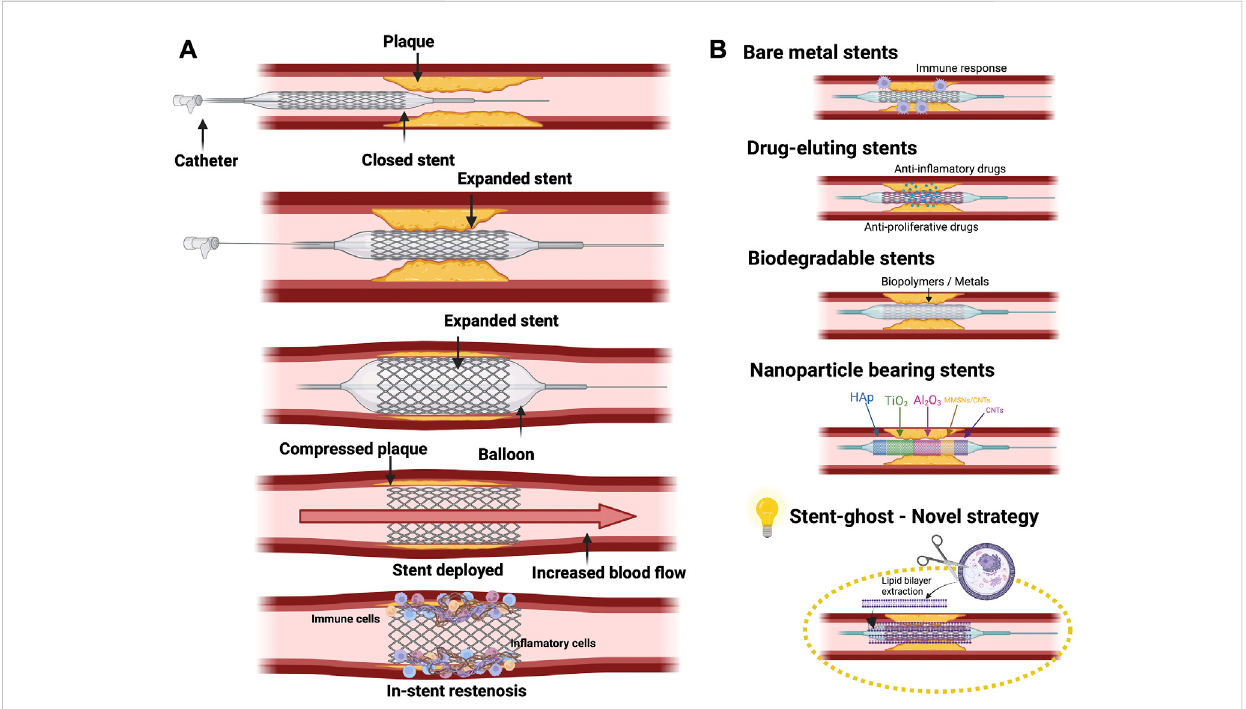
FIGURE 2 (A) Representative stent implantation procedure, including implantation, expansion and lastly, in stent-restenosis formation. (B) Representation of different Stents used in clinic: Bare metal stents; Drug-eluting stents; Biodegradable stents; nanoparticle bearing stents. The use of a “ Stent ghost ” which is a stent coated with cell membranes could represent an innovative therapy to escape the immune